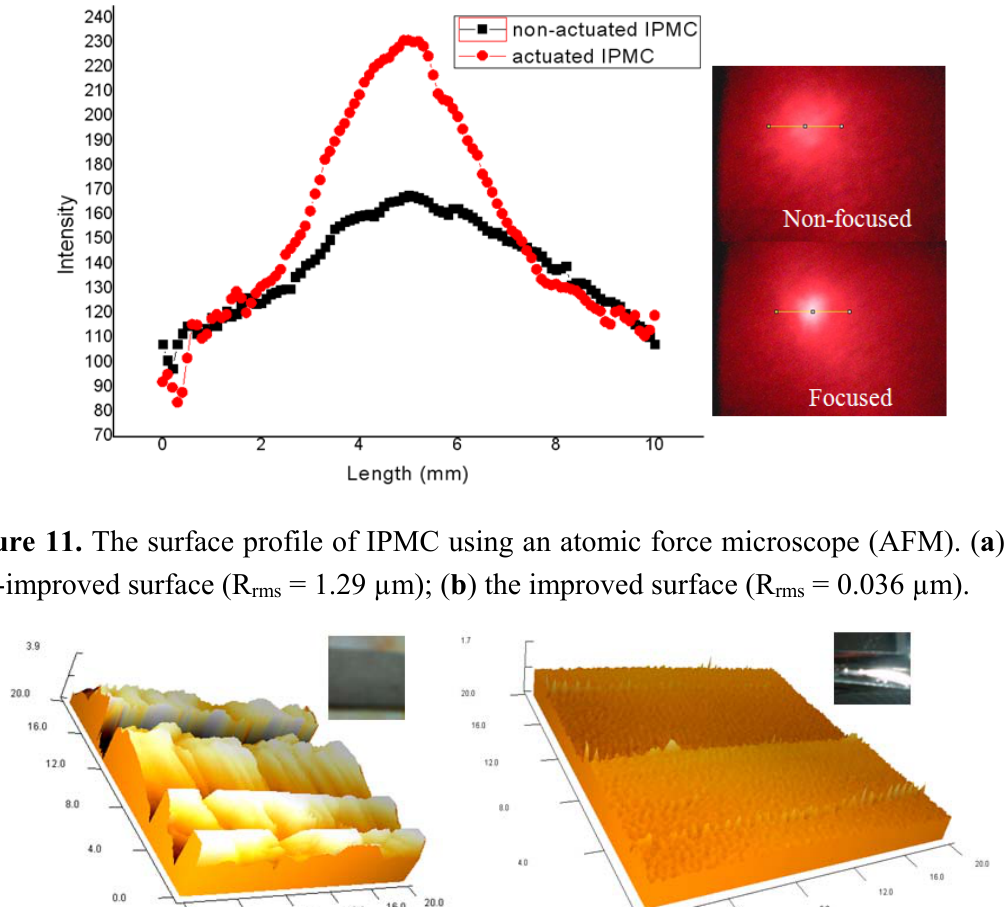
Figure 10. The intensity profile of the laser beam spot with non-actuated IPMC (non-focused) and actuated IPMC (focused).